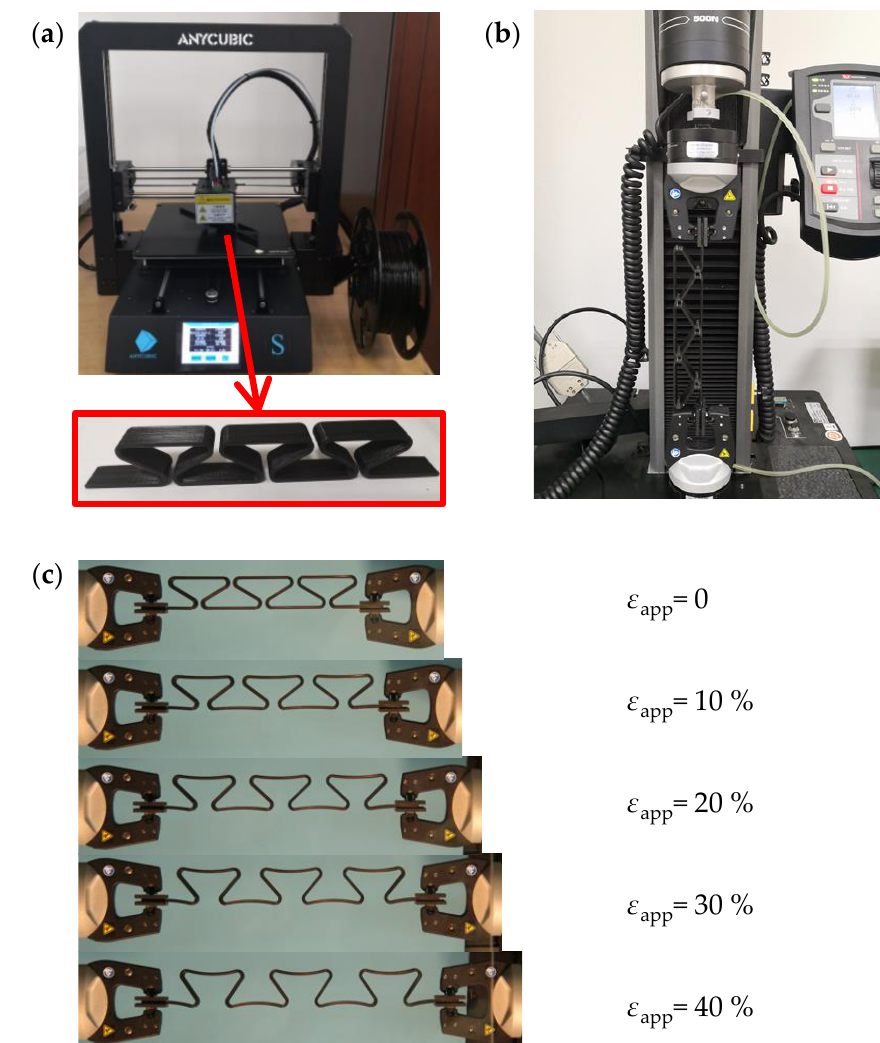
Figure 6. The experiments of the horseshoe-shaped structure. ( a ) The horseshoe-shaped structure prepared by 3D printer; ( b ) The stretching test through stretcher machine; ( c ) The stretching test results obtained by digital camera.